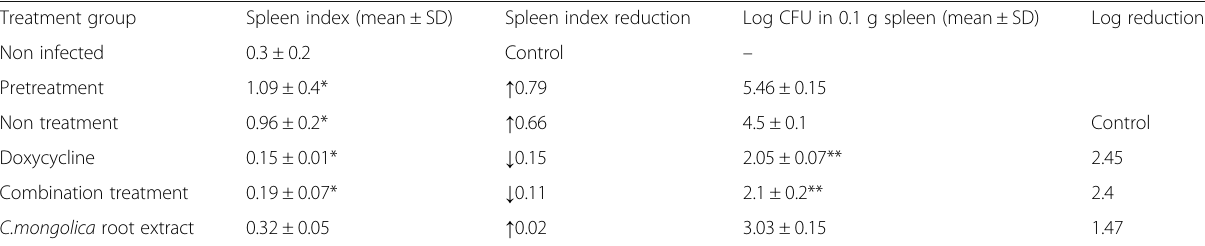
Table 1 Antibacterial efficacies of C. mongolica root extract, antibiotic, and the combination of both treatments in B. melitensis - infected BALB/c mice